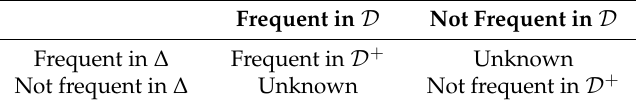
Table 1. Cases for item to be frequent and the